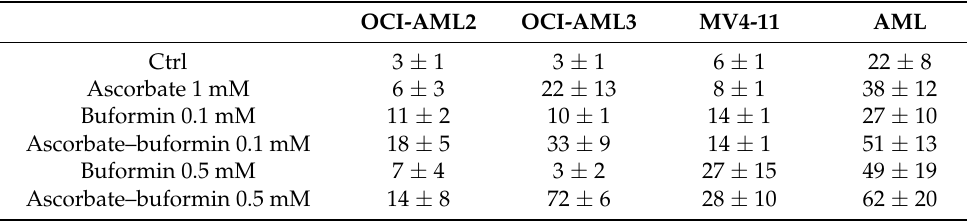
Table 7. Apoptosis effect in AML cell lines and in primary AML blasts treated with ascorbate plus